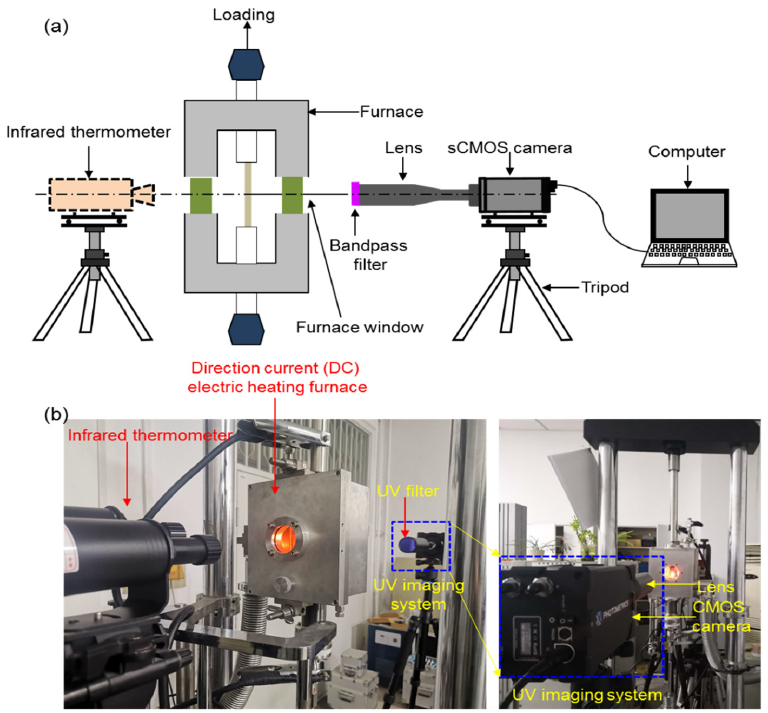
Figure 5. ( a ) Schematic illustration and ( b ) the real experimental setup of temperature and defor- mation measurement